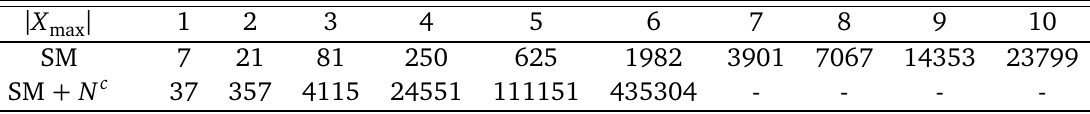
Table 2: Number of non-trivial distinct solutions for the anomaly-free U ( 1 ) | ≤ 10, and for SM fermions with three generations of of the SM fermions for | X max | ≤ 6 as obtained in [ 38 ] RH neutrinos for | X max